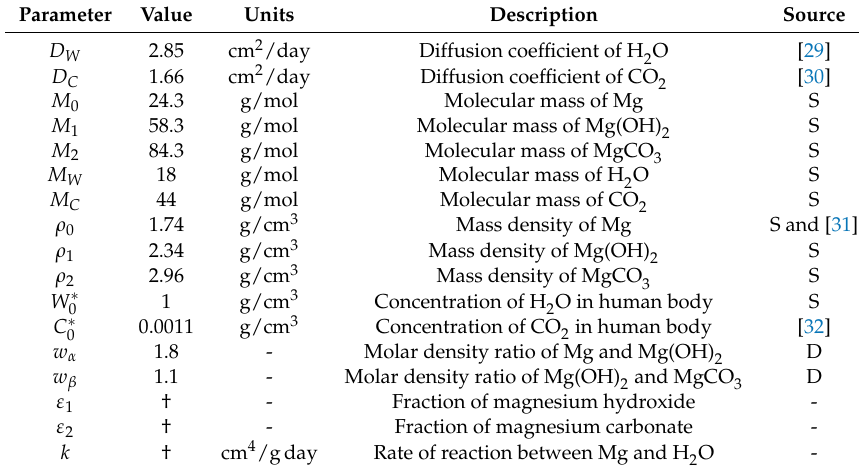
Table 3. List of model variables, their interpretation and, where possible, estimated values from the literature. † unknown parameters in the model. “S” indicates standard textbook references and “D” derived from formula in Table